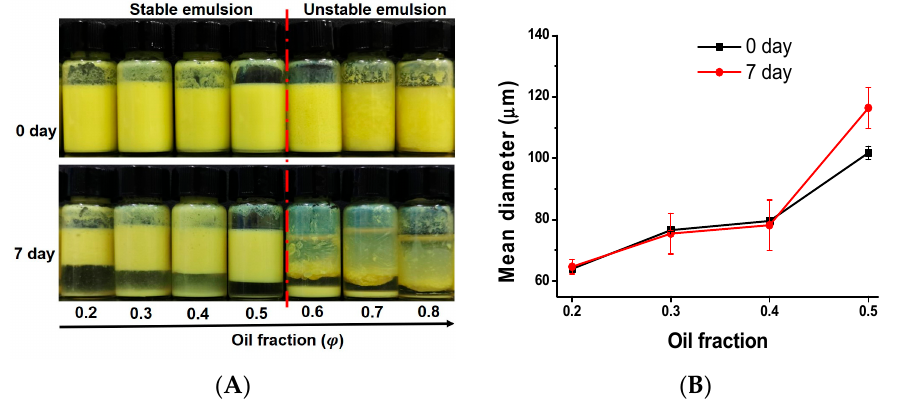
Figure 7. Visual appearances ( A ) and droplet size ( B ) of emulsions prepared by antisolvent quercetin particles (the antisolvent ratio of quercetin particles was 1:1, c = 1%) at various oil fractions after storage for 0 day and 7 days.